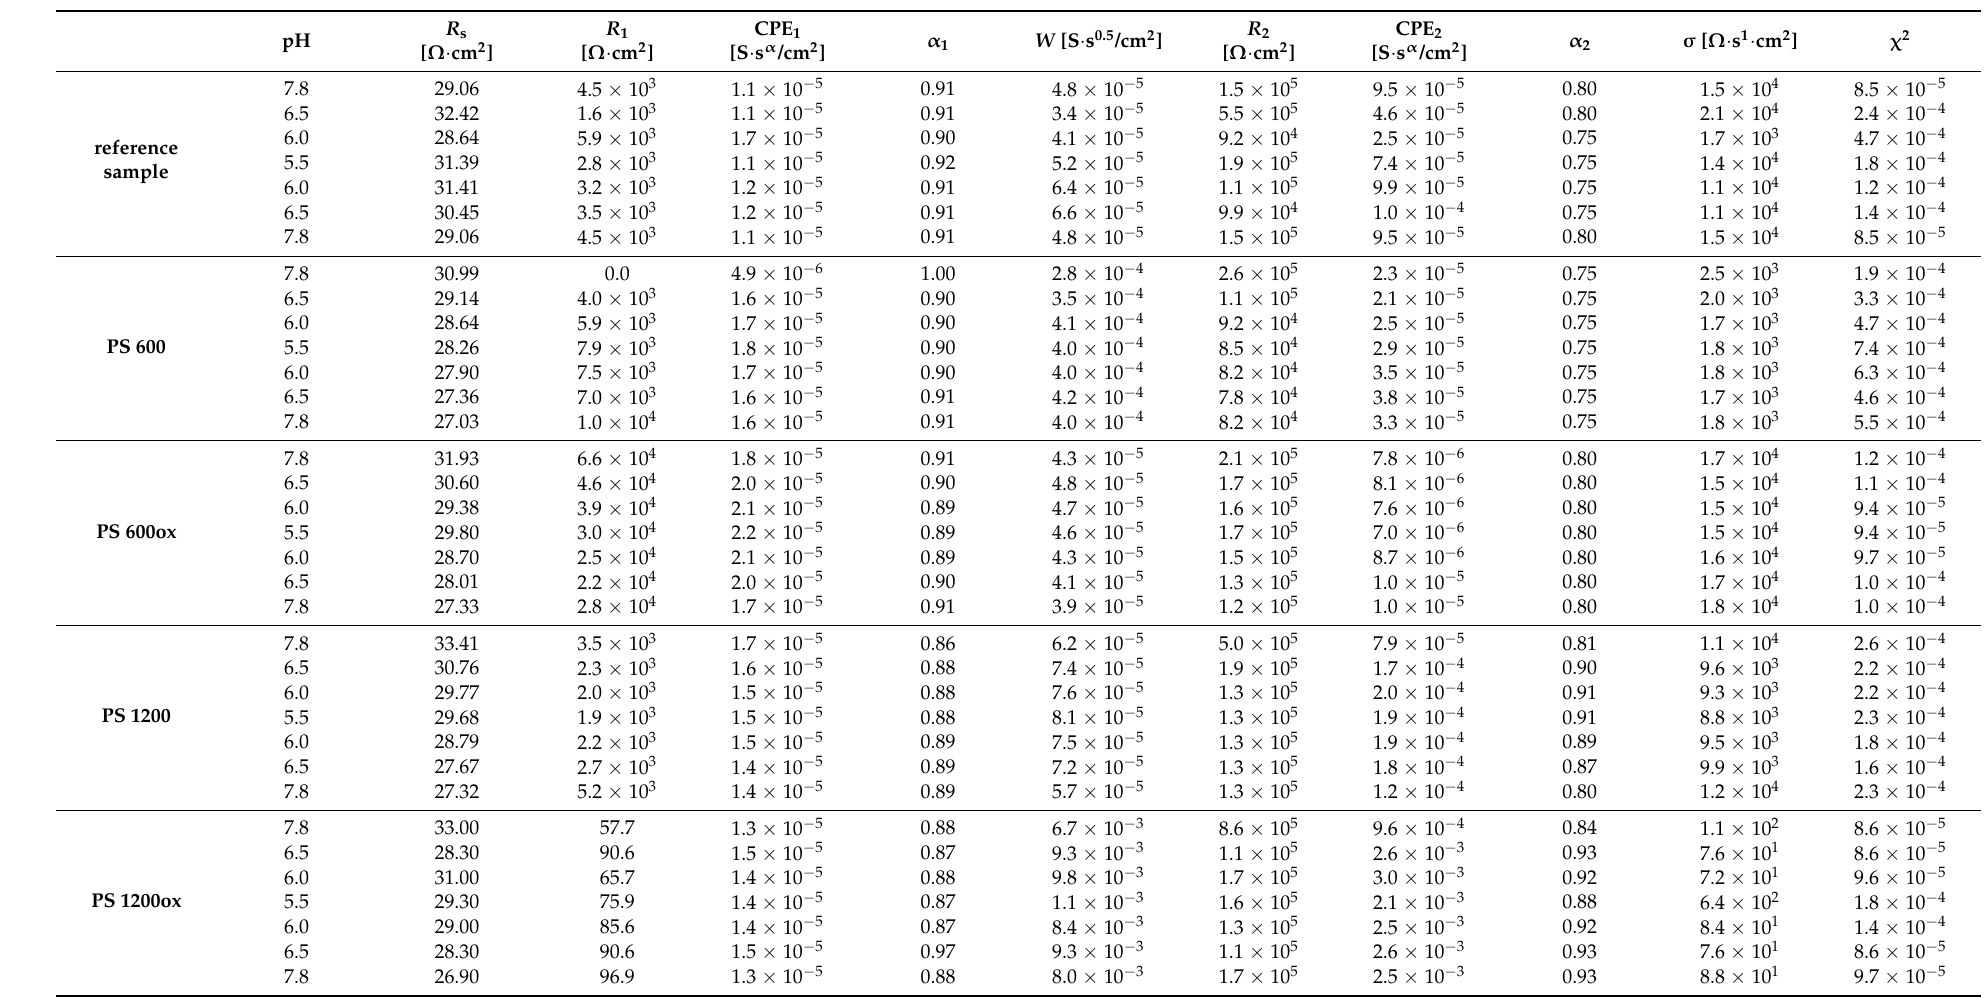
Table 5. Results of modelling the impedance spectra for all